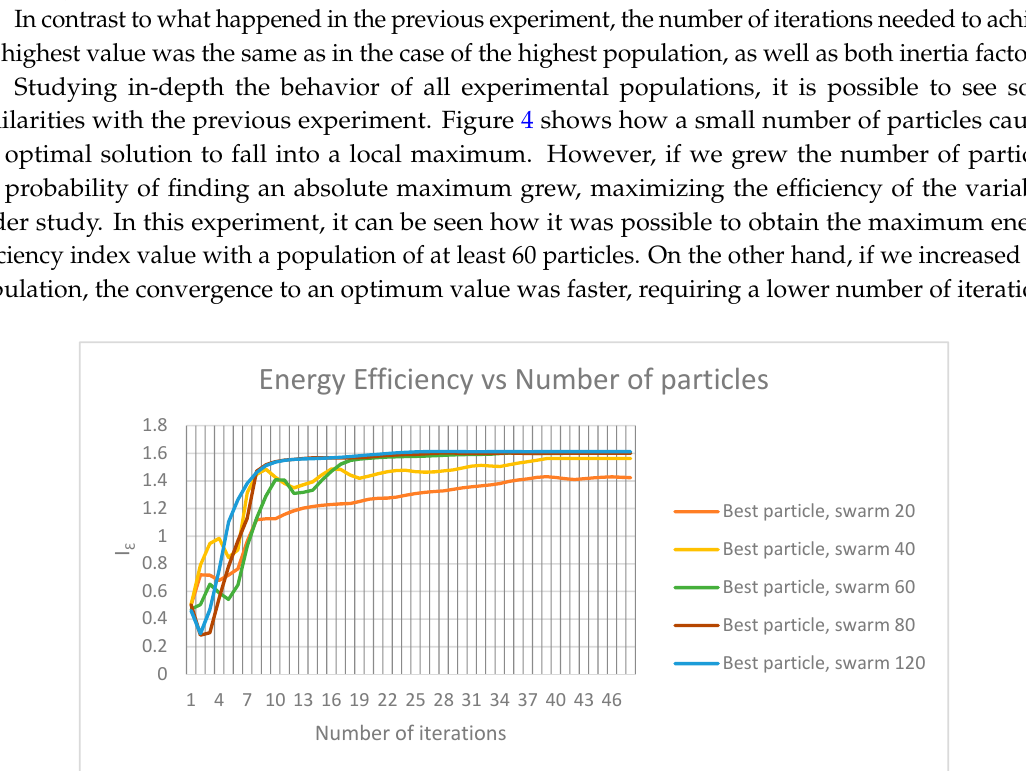
Figure 4. Evolution of the best particle for different swarms.